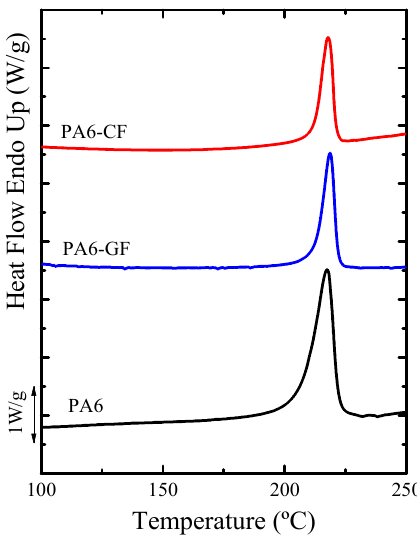
Figure 3. First DSC heating scans for neat PA6 and the composites with glass fiber (GF) and carbon fiber (CF). Scans presented in the image are not standardized by the weight fraction of PA6. Table 2. DSC-derived data for neat PA6 and its composites with glass and carbon fiber. 1st Heating Cooling and 2nd